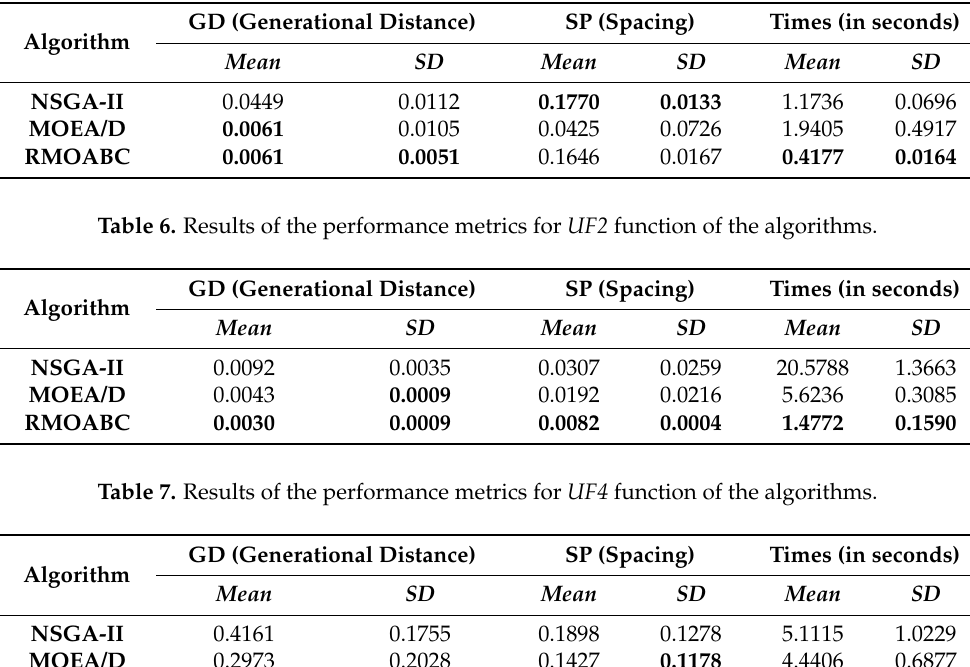
Table 5. Results of the performance metrics for ZDT6 function of the algorithms.